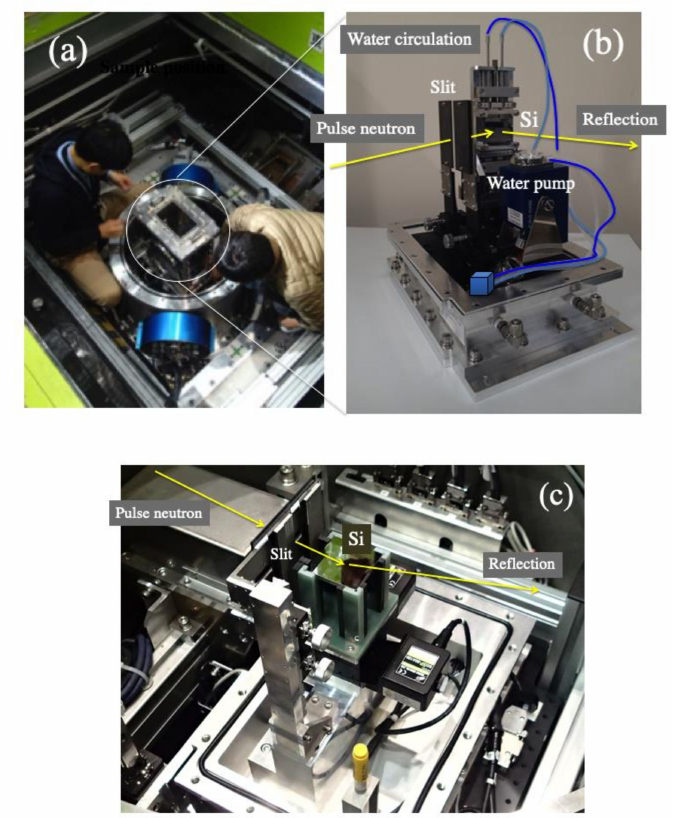
Figure 9. ( a ) Air chamber for grazing-incidence scattering. ( b ) Sample stage for grazing incidence scattering (vertical geometry). ( c ) Sample stage for grazing incidence scattering (horizontal